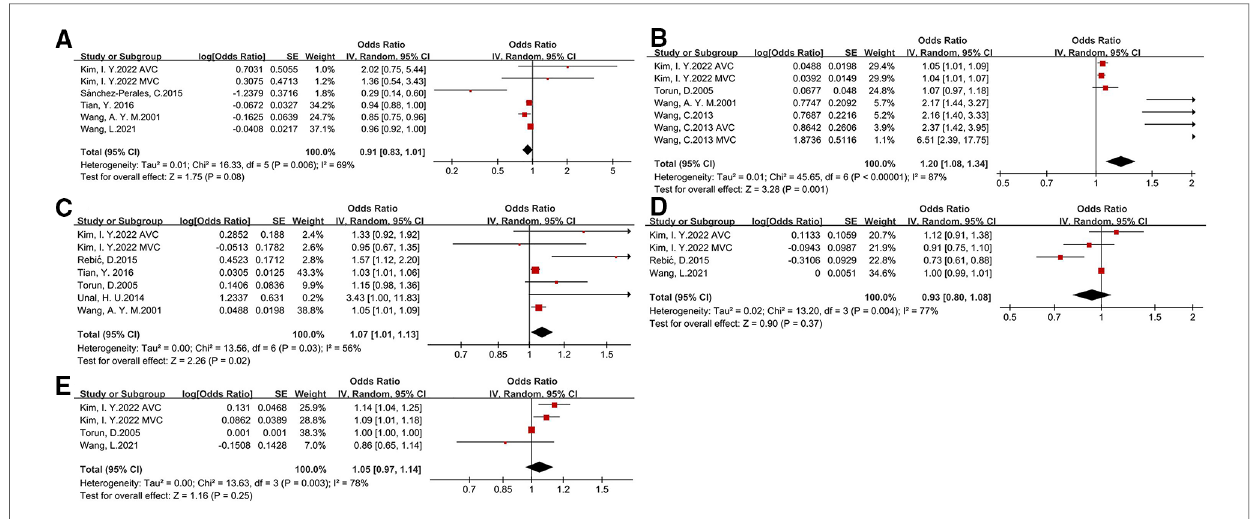
FIGURE 3 Laboratory risk factors for development of CVC in CKD patients [( A ) albumin, ( B ) calcium*phosphate, ( C ) C-reaction protein, ( D ) hemoglobin, ( E ) parathyroid